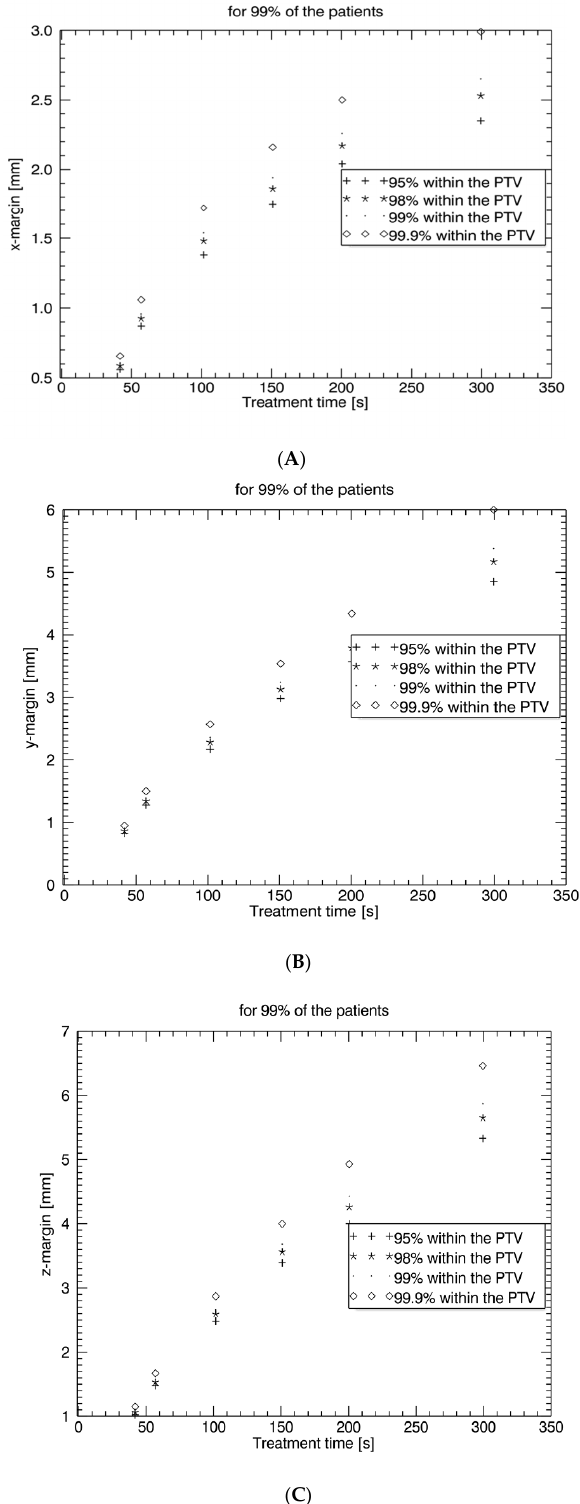
Figure 2. PTV safety margin curves dependent on time interval I = 50–300 s with a 95%, 98%, 99%, and 99.9% probability (for 99% of the patients) in the x-direction (left/right) ( A ), the y-direction (anterior/posterior) ( B ), and the z-direction (inferior/superior) ( C ).